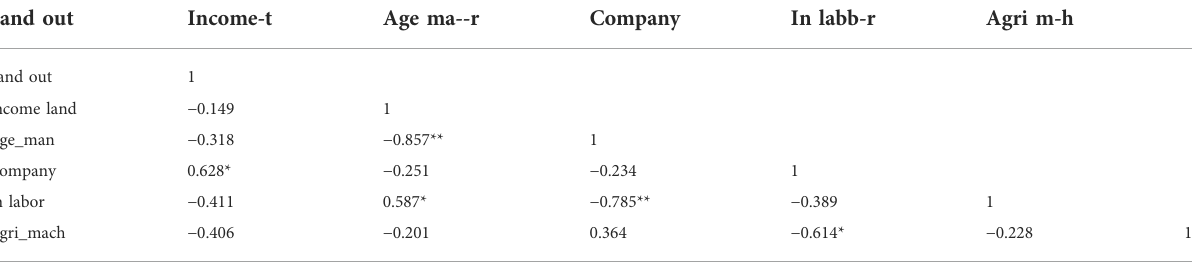
TABLE 6 Correlation analysis of all variables.